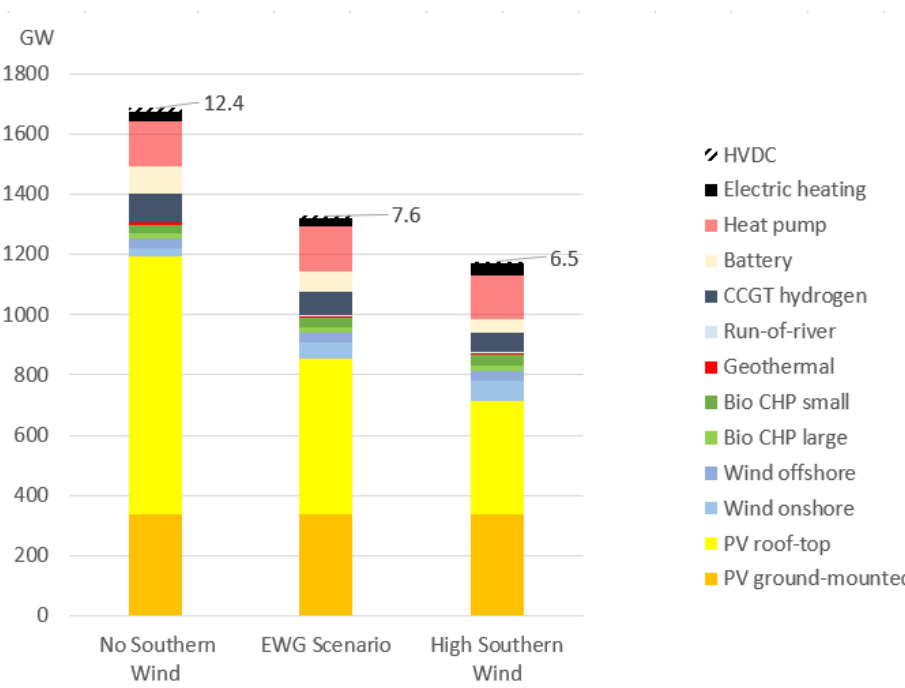
Figure 5. Capacities for a CO 2 -free energy system in northern and southern Germany for the three sce- narios of EWG Scenario, No Southern Wind, and High Southern Wind: forgoing wind power expansion in southern Germany doubles the required high-voltage direct-current (HVDC) grid